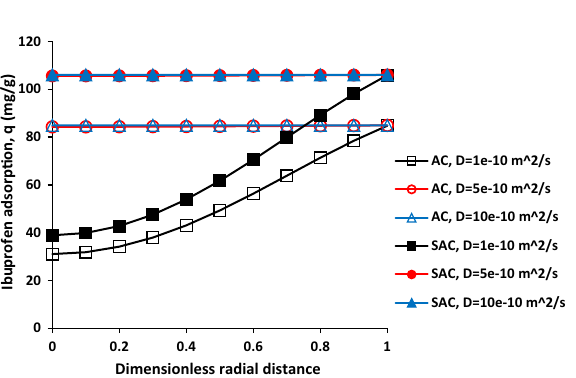
Figure 9. Ibuprofen adsorption as a function of dimensionless radial distance for AC and SAC with different solute diffusion coefficient, initial ibuprofen concentration = 100 mg/L, T = 298 K, pH = 2, AC porosity = 0.392, SAC porosity = 0.474, adsorbent dosage of 0.5 g/L, and particle radius = 163